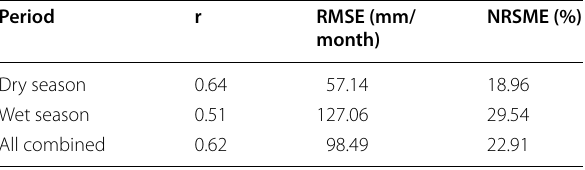
Table 3 The performance of TerraClimate monthly runoff in Brantas watershed